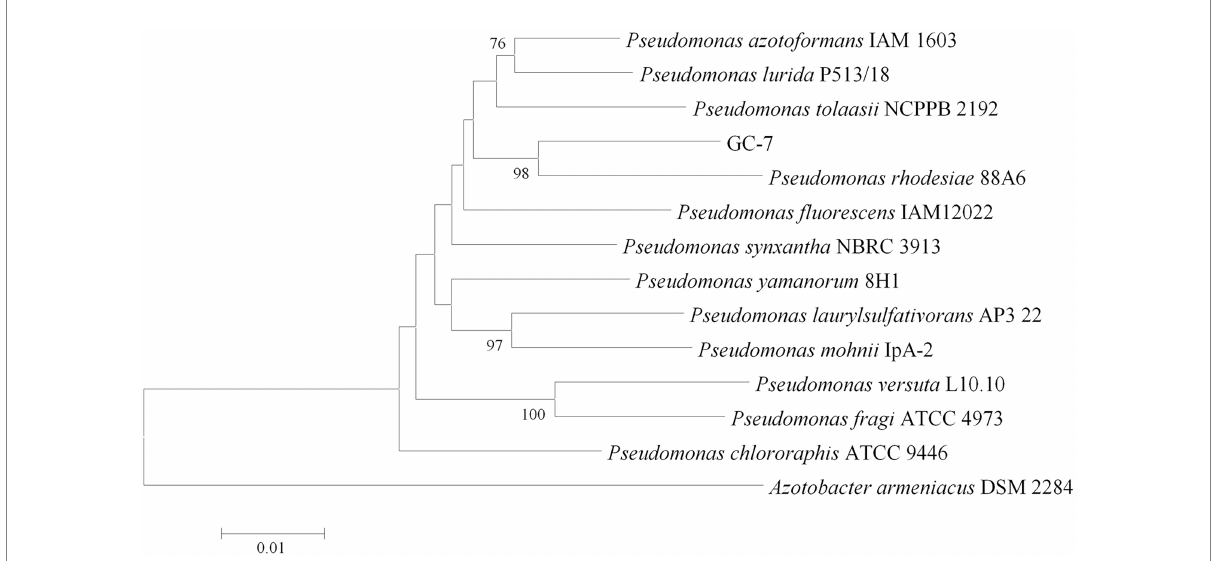
FIGURE 1 Phylogenetic tree of isolate GC-7 based on 16S rRNA and gyrB gene sequences. The neighbor-joining method was used to construct the tree, which shows the relationships between isolate GC-7 and closely related species. Only values greater than 50% are provided. The scale bar indicates 0.01 nucleotide substitutions per nucleotide position. The numbers at the nodes represent percentages after 1,000 bootstrap replicates.